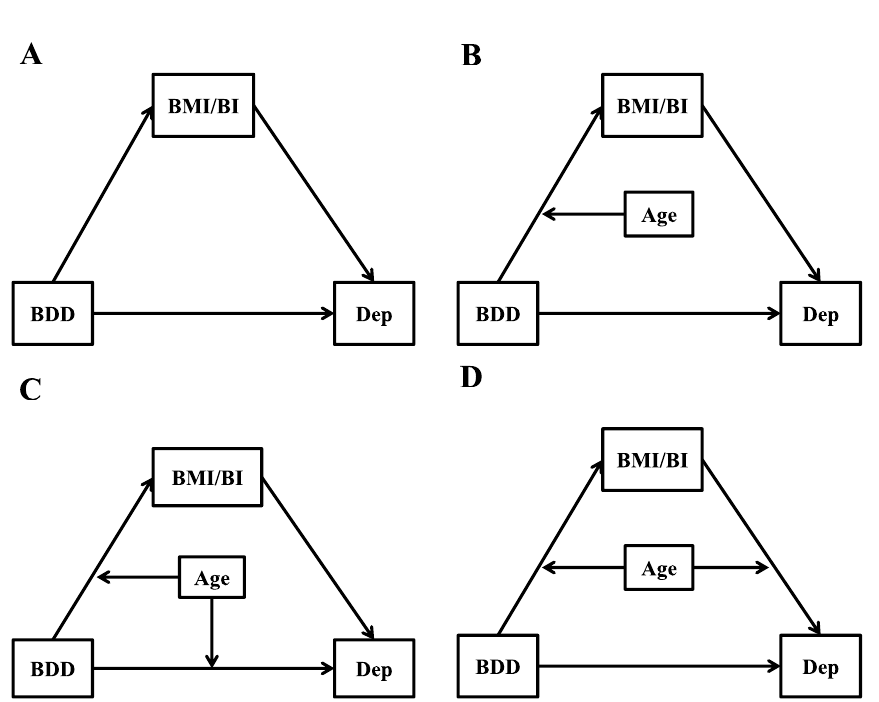
Fig. 1 A Model 1 mediation model. B Model 2 moderated mediation. C Model 3 moderated mediation. D Model 4 moderated mediation. Conceptual models link body dysmorphic disorder, body mass index, body image, and depression among Pakistani students population. This study suggested four models focused on the mediation of body mass index, body image, and the moderation effect of age